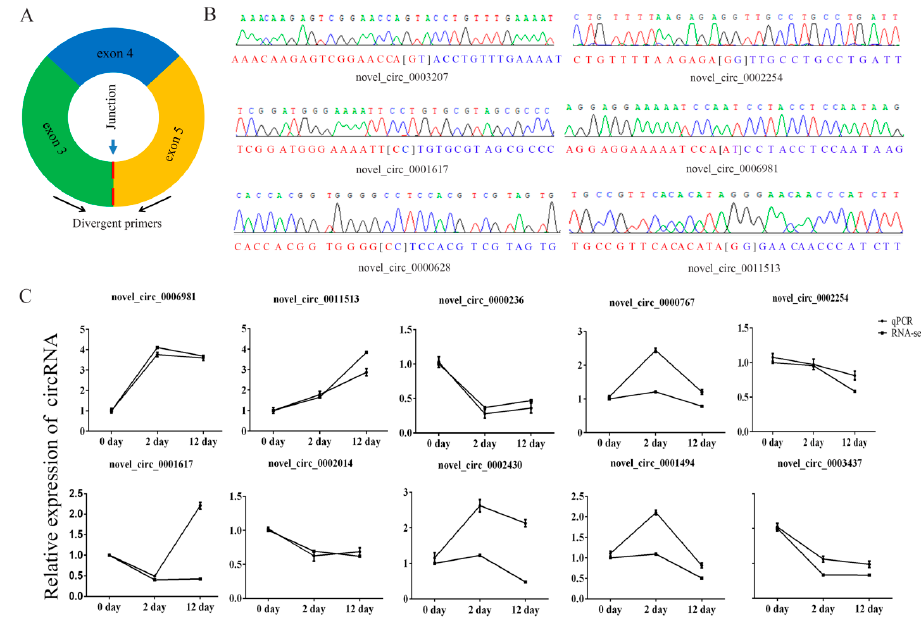
Figure 5. Verification of putative circRNAs. ( A ) Schematic illustration of the design of primers for circRNAs used in qRT-PCR. ( B ) Sanger sequencing confirmed back splicing site of representative circRNAs. ( C ) Change in circRNA levels between day 0, day 2, and day 12 groups. Day 2 / day 0 and day 12 / day 0 ratios for 10 circRNAs were based on the RNA-seq data and the expression of di ff erentially expressed circRNAs as determined by qRT-PCR (three biological replicates, each done in